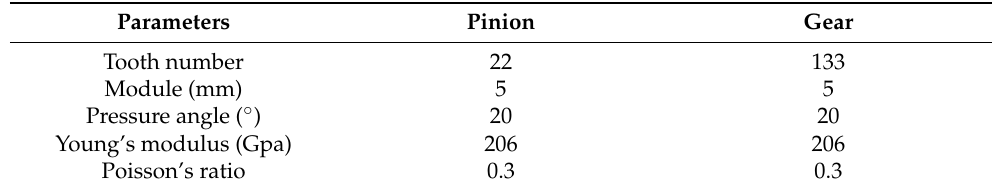
Table 2. Gear system